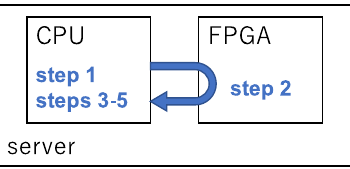
Figure 7. Schematics of the iterative fractional-cost method using SB. Only the discrete optimization step (step 2), in which the QUBO Hamiltonian in Eq. (3) is minimized, is executed in the